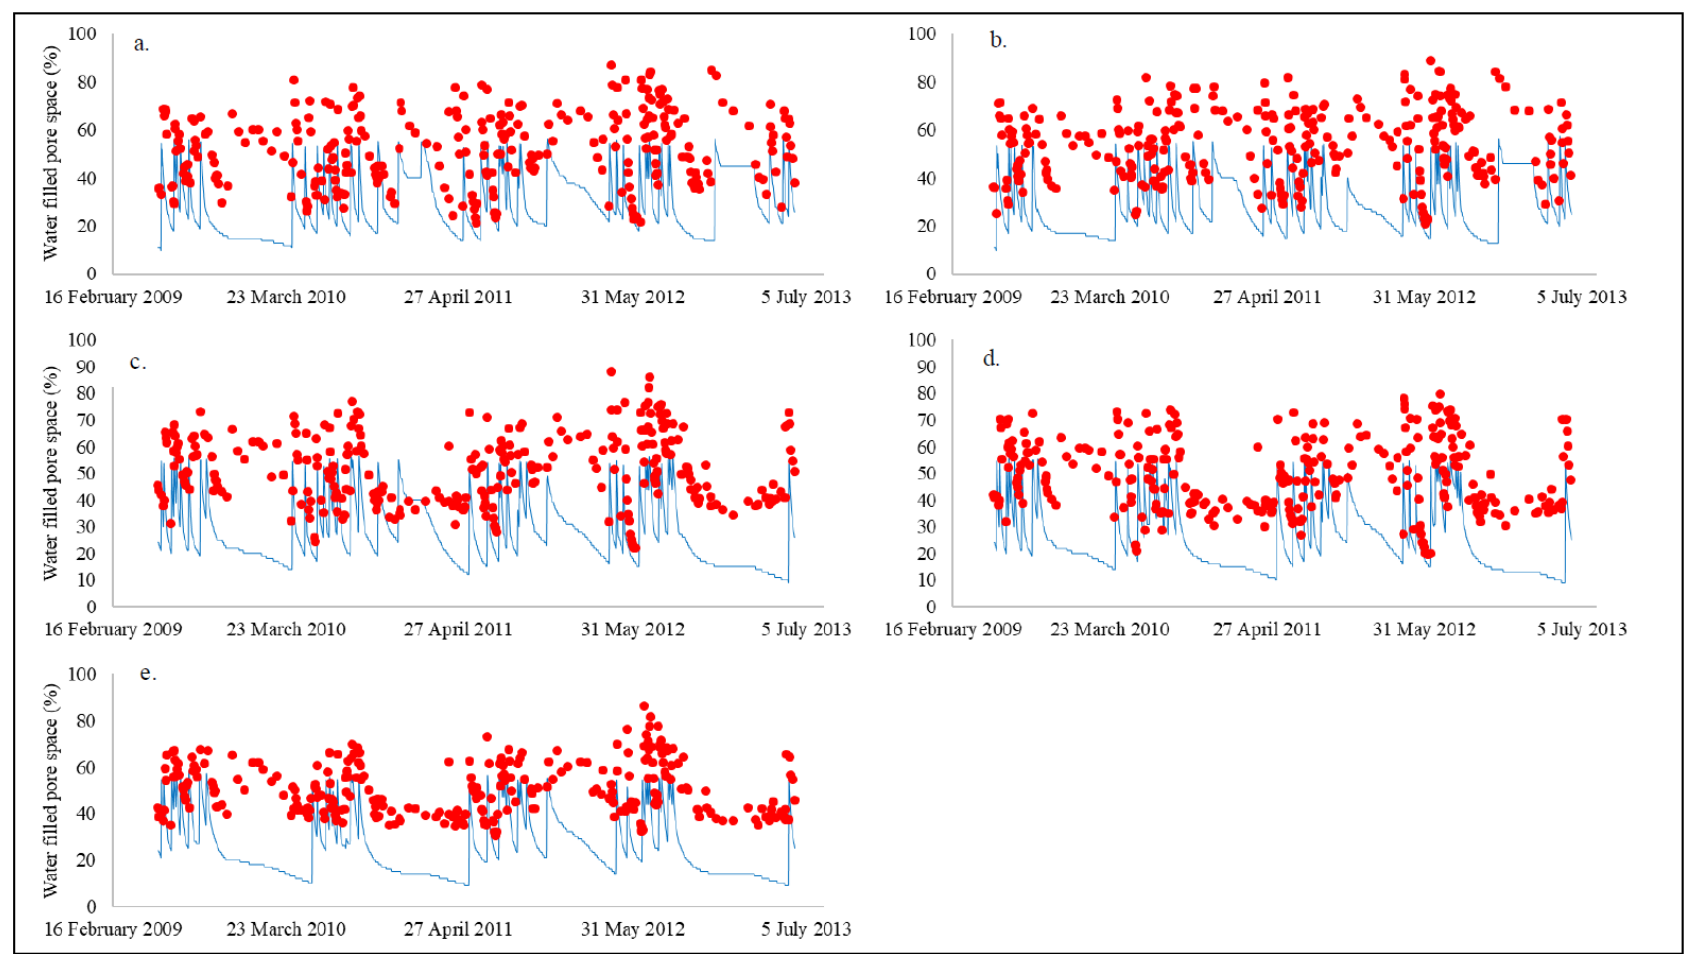
Figure 2. Comparisons between field observed ( ● ) and DNDC simulated (line) daily WFPS (%) at the conventional winter wheat-summer maize double-cropping system (Chem. W/M; a.), optimized winter wheat-summer maize double-cropping system (Opt. W/M; b.), winter wheat-summer maize-fallow-spring maize system (W/M-M; c.), winter wheat-summer soybean-fallow-spring maize system (W/S-M; d.), and spring maize system (M; e.) over the experimental period from June 2009 to June 2013. The r 2 ranged from 0.23 to 0.41 and the overall r 2 is 0.33.